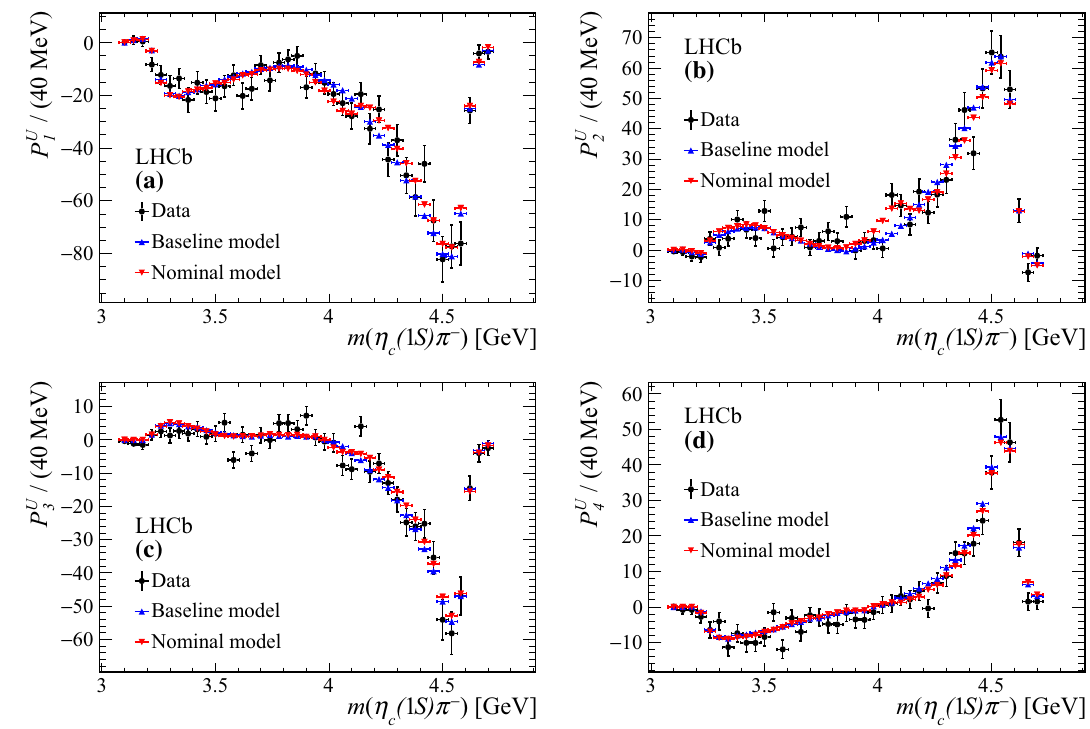
Fig. 11 Comparison of the first four η c π − Legendre moments determined from background-subtracted data (black points) and from the results of the amplitude fit using the baseline model (red triangles) and nominal model (blue triangles) as a function of m (η c π − )